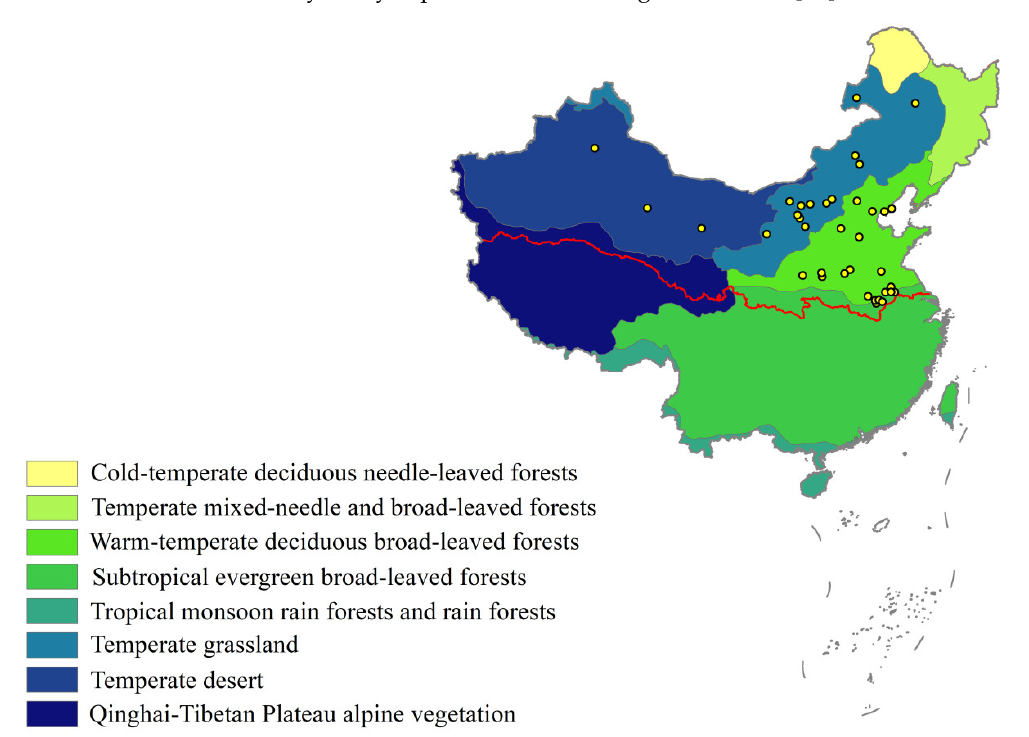
Figure 1. Distribution patterns of the 38 wetlands with relatively sufficient sampled bird community data (yellow points) in North China. The different colors in the background mean different vegetation types, which is based on the information from Vegetation of China [22]. The red line is the border between North and South China, which was revised based on the information from [23].